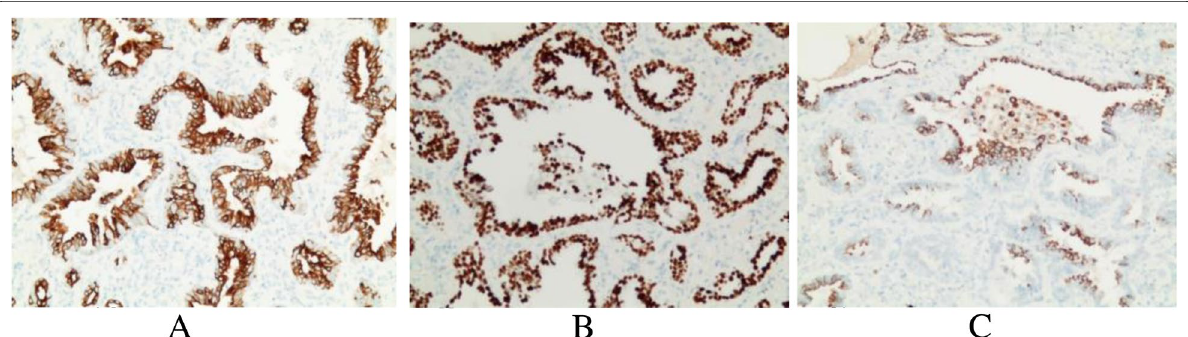
Fig. 4 A Ciliated cells, mucous cells, and basal cells positive for CK7 (EnVision, negative in the luminal cells. C Cells lining the cavity are positive for CEA (EnVision,